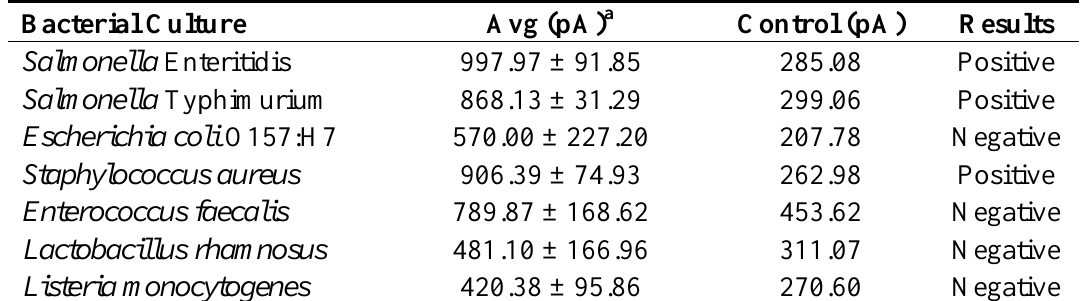
Table 1. Specificity of the fiber-optic sensor for S . Enteritidis when compared with other live microorganisms.